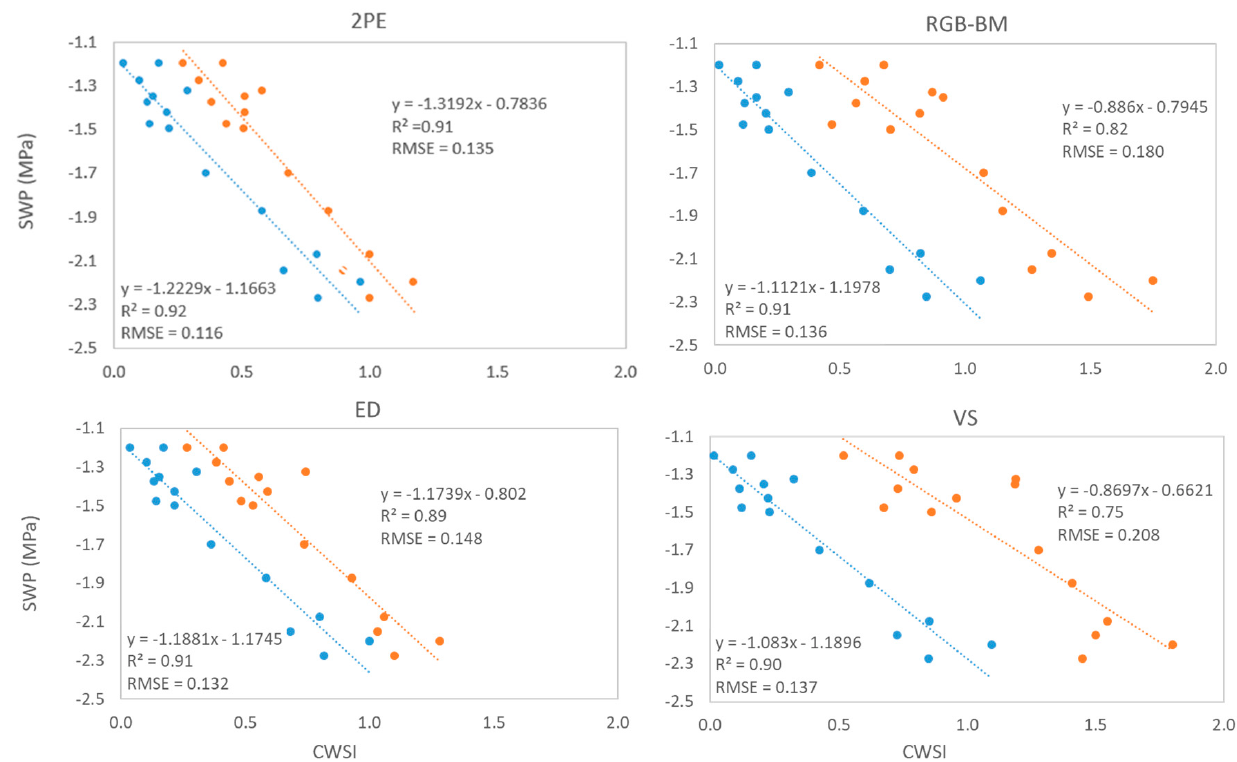
Figure 8. Linear regression model of SWP and CWSI for the 2-pixel erosion (2PE), edge detection (ED), vegetation segmentation (VS), and RGB binary masking (RGB-BM) canopy extraction methods. Crop water status index (CWSI) with Tcanopy (°C) calculated using the average 100% (CWSI_T100%) (red points and lines) and the average of the coolest 33% (CWSI_T33%) (blue points and lines) of canopy pixels. Twet = lowest 5% of canopy pixels, and Tdry = Tair + 2 °C. Each point represents a measurement tree (n = 15).